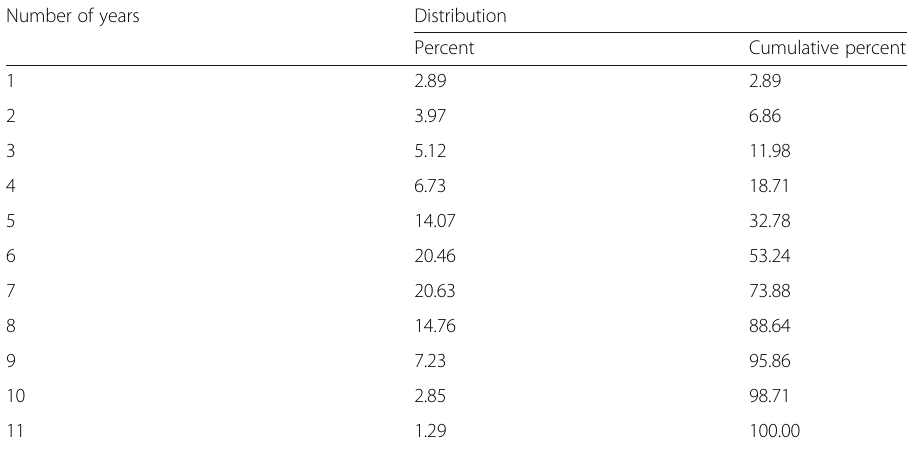
Table 7 Distribution of temporary foreign workers by the number of years with positive total employment earnings in the sample, 1996 to 2012 Number of years Distribution Percent Cumulative